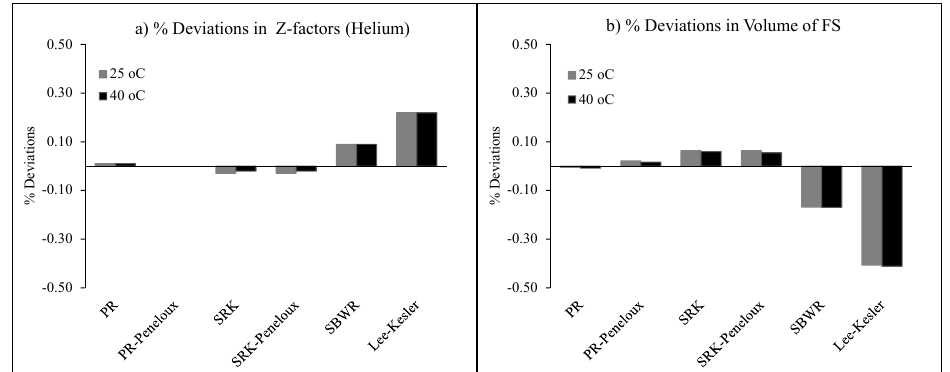
Figure 2 . Effect of Equation of State on Free-Space (a) Variation in Z-factor of helium gas by EOS (b) Corresponding variation in volume of free space.